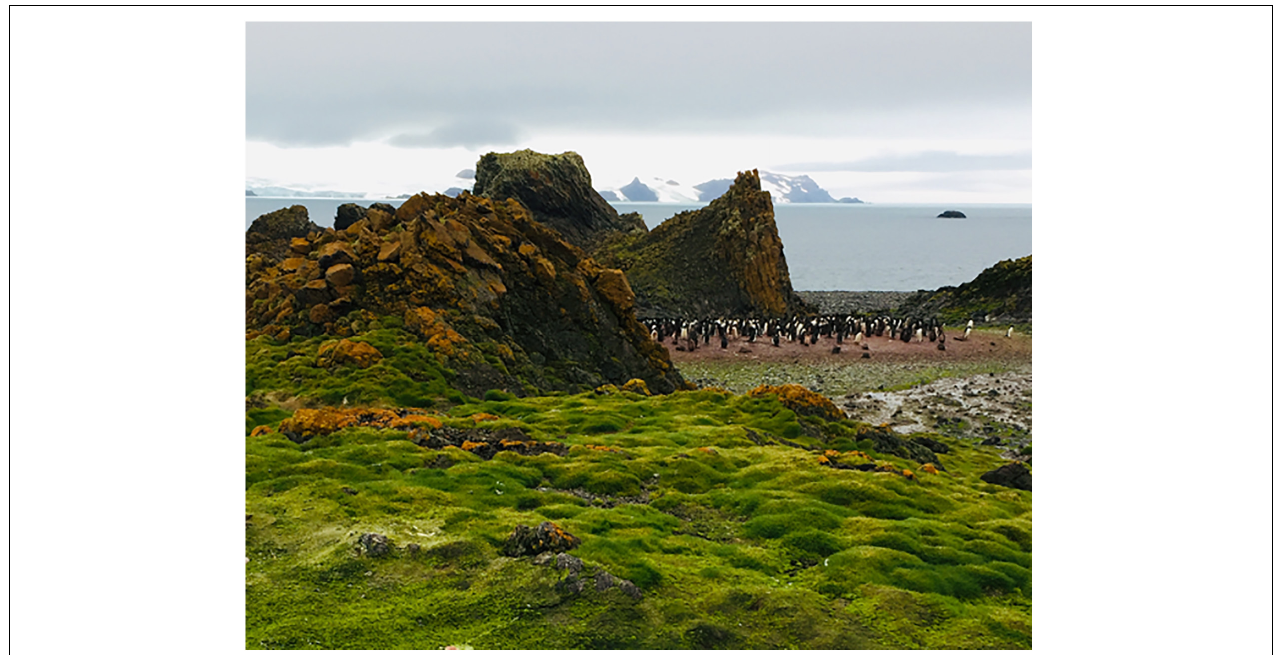
FIGURE 1 | Antarctic plant community growing near a big penguin colony in the study site (Admiralty bay, King George Island, South Shetland, Antarctica).